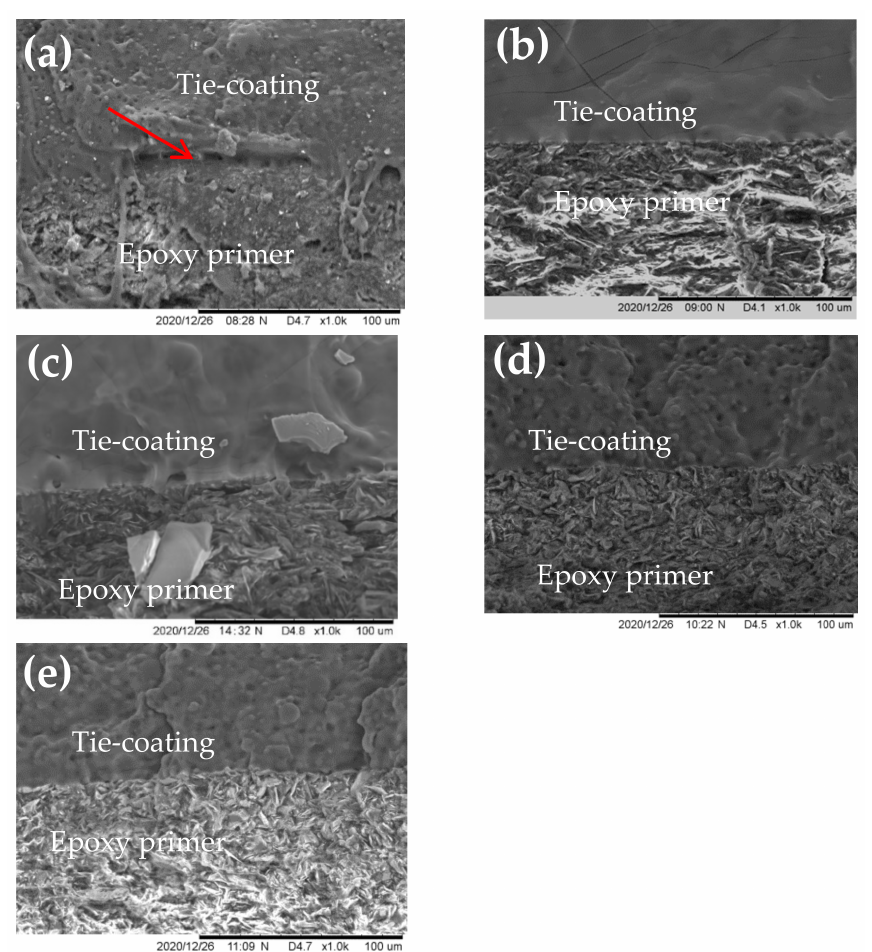
Figure 9. SEM images of fracture (Epoxy primer /Tie-coating) ( a ) ES-9, ( b ) ES-18, ( c ) ES-26, ( d ) ES-34, ( e ) ES-41.